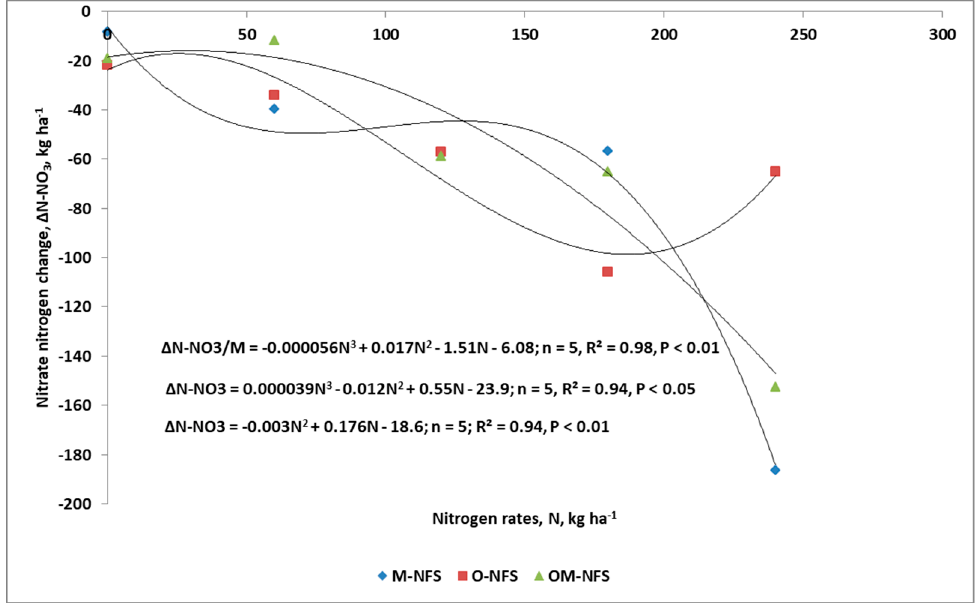
Figure 4. Trends in the N nitrate content change during the stem elongation phase of WOSR growth for three nitrogen fertilization systems (NFSs). M-NFS, O-NFS, OM-NFS—mineral, organic, organic-mineral, respectively.